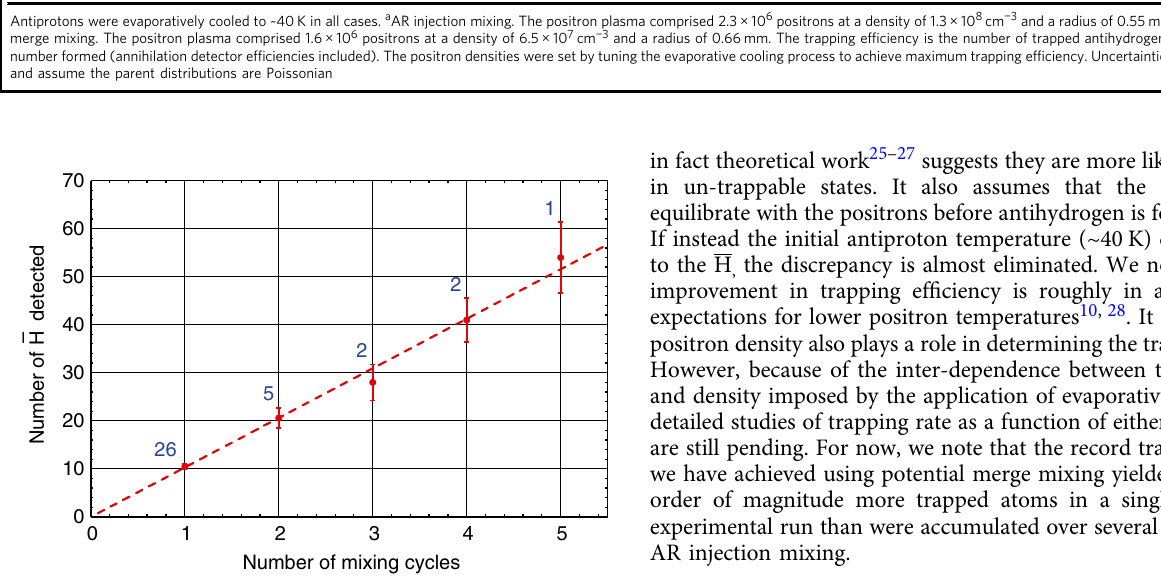
Fig. 3 Antihydrogen stacking. The number of antihydrogen atoms detected when the magnetic minimum trap is ramped down after one or more consecutive mixing cycles. Each mixing cycle in a sequence is separated by ~4 min. The error bars are statistical and the number of replicates is indicated above each data point. The dashed line is a linear fi t to the data giving an average trapping rate of 10.5 ± 0.6 detected antihydrogen